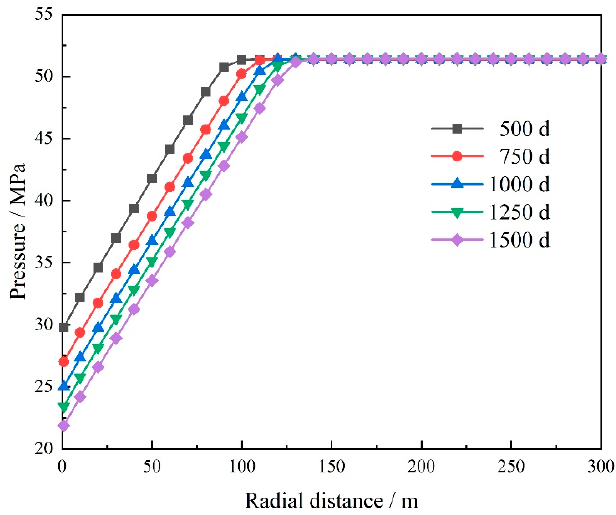
Figure 8. Radial pressure distribution at different times.